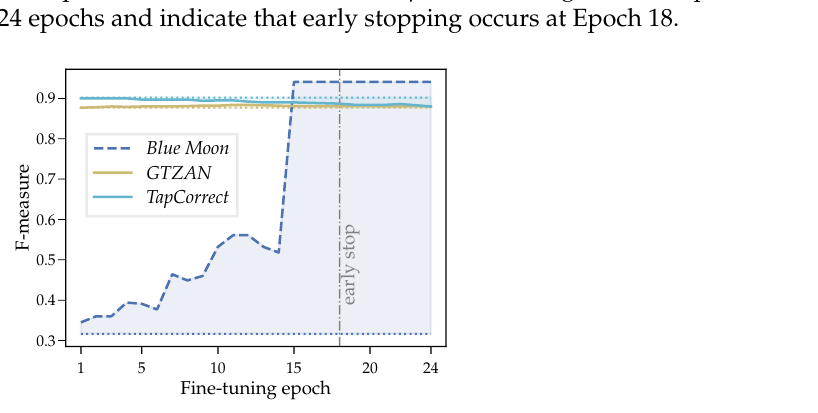
Figure 10. Evolution of F-measure during fine-tuning of Blue Moon on the GTZAN and TapCorrect datasets. Solid lines correspond to the fine-tuned model and dotted lines to the baseline